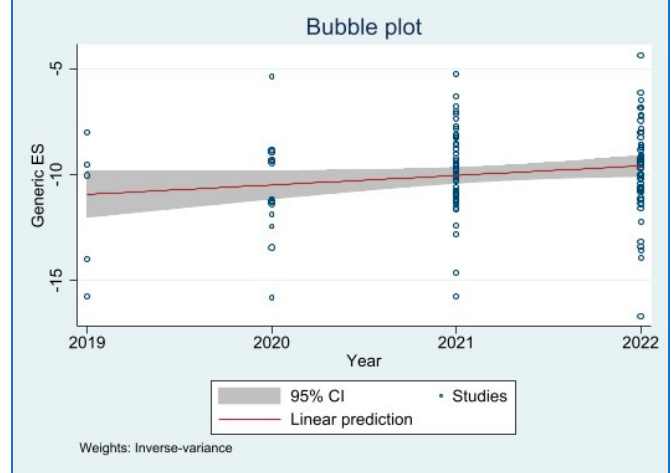
Figure 4. Meta-regression based on year.